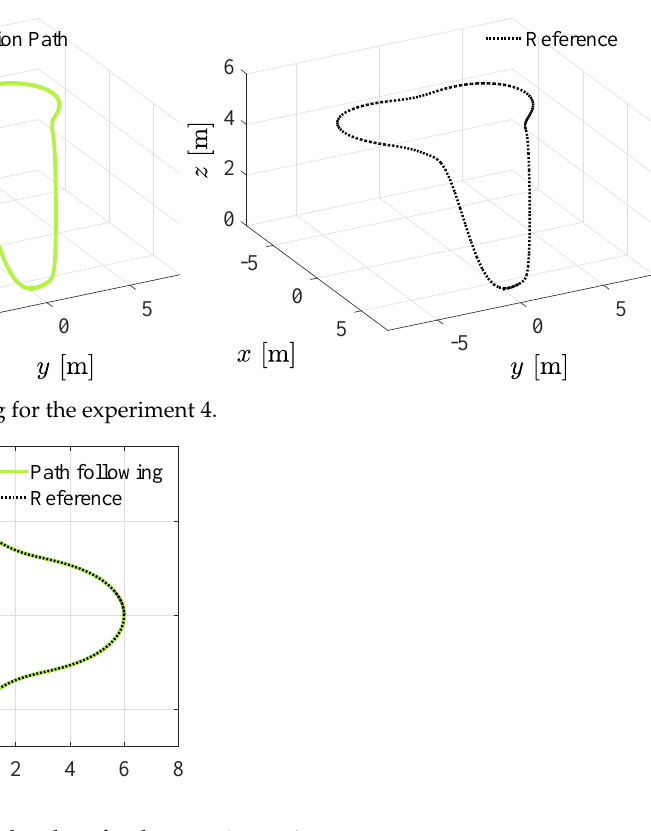
Figure 15. Path following on the plane for the experiment